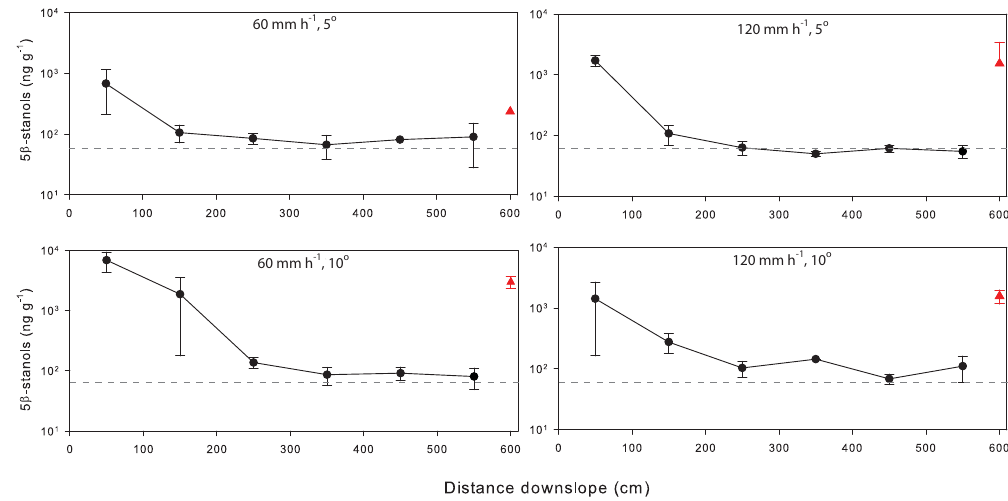
Figure 10. Plots showing the change in average concentration of 5 β -stanols in soil cores downslope for each of the slurry-treated experiments. The dashed line shows the mean concentration in the control soil, and the triangles represent the average concentrations in the eroded sediment.